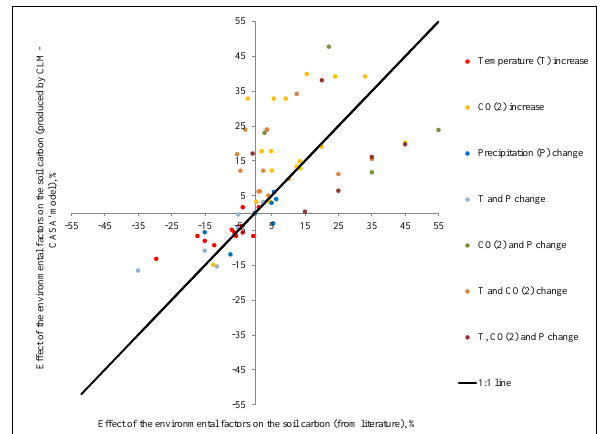
Fig. 3. Comparison of change in soil carbon in response to environ- mental factors reported in the literature to the change obtained in this